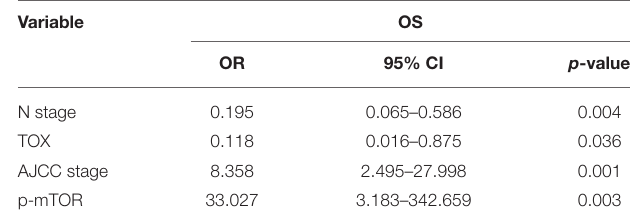
TABLE 4 | Multivariate analysis for